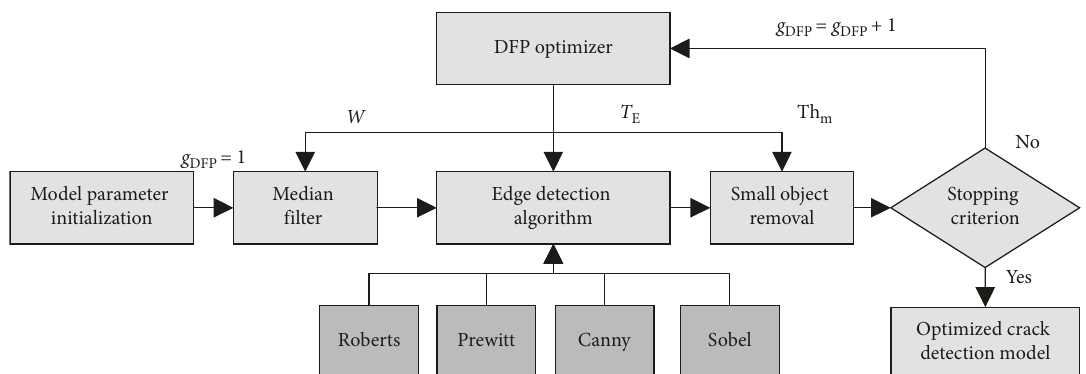
Figure 7: The proposed model for recognition of cracks on the concrete wall surface (MO-EDCR). Note: W denotes the window size parameter. T E is the edge detection threshold. Th m is a threshold parameter used in the morphological operation for small object